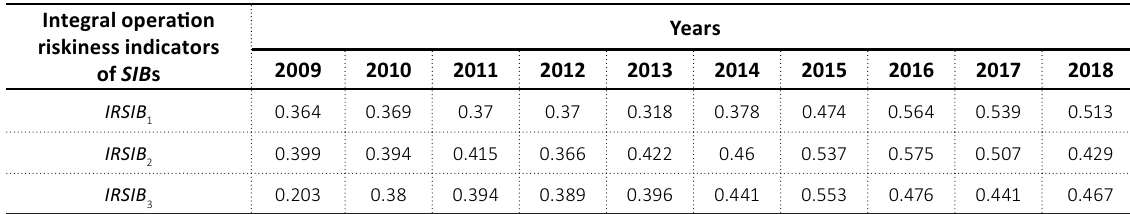
Table 2. Findings illustrating quantitatively assessed operation riskiness of Ukrainian systemically important banks (within individual groups)